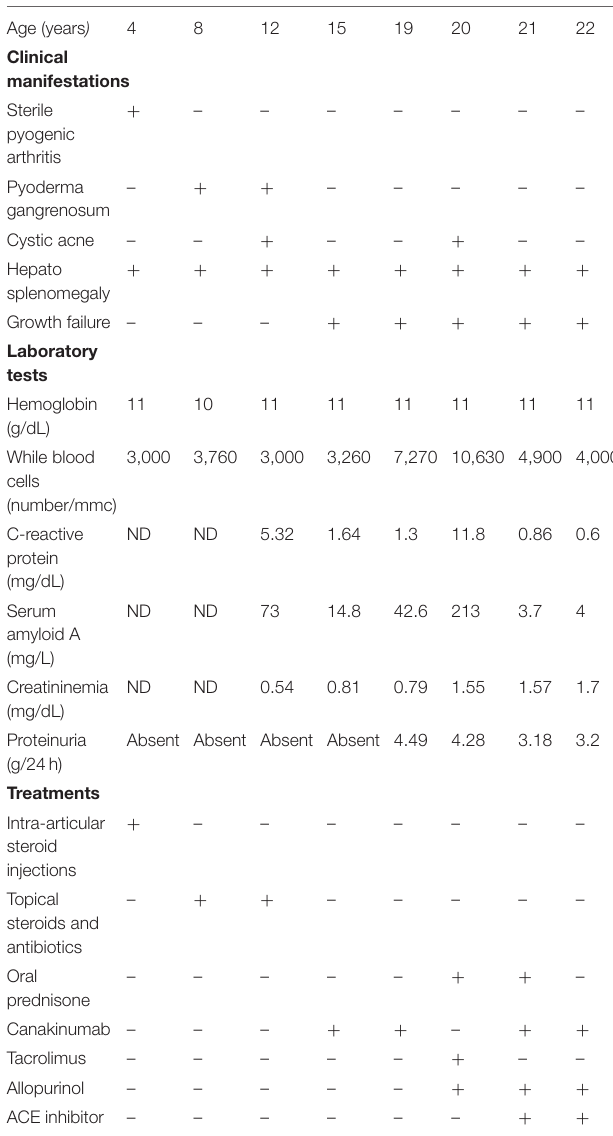
TABLE 1 | Characteristics of the